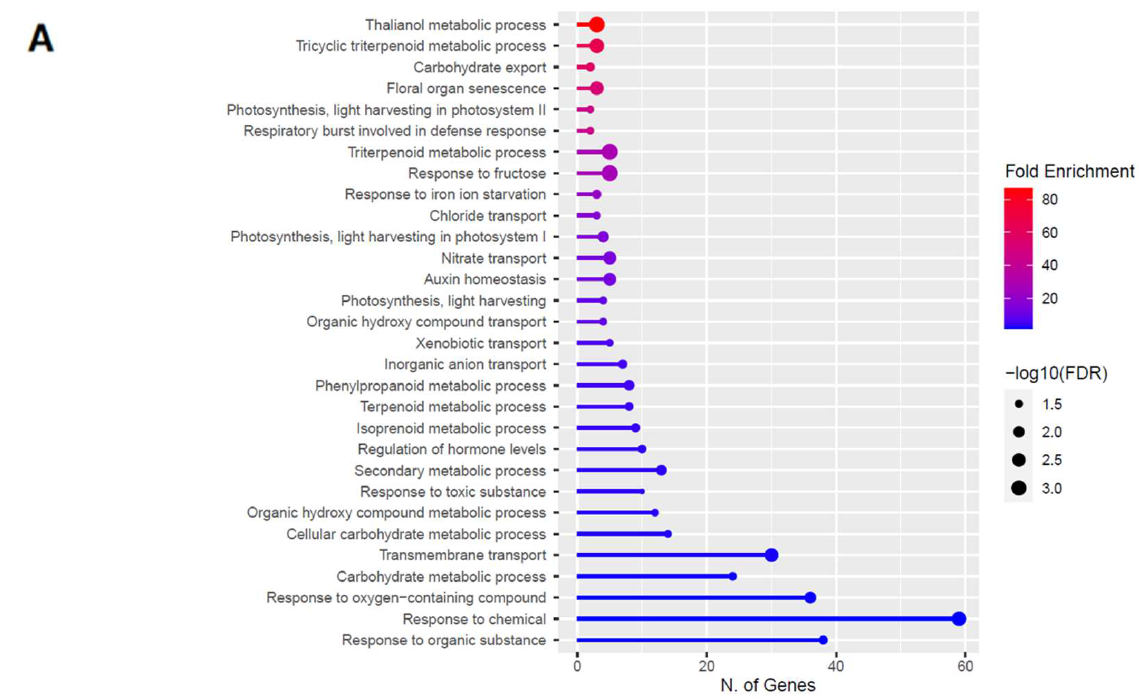
Figure 5. Gene enrichment analysis for upregulated genes after 60 s plasma treatment. Lollipop diagrams provide information about GO fold enrichment, significance (FDR in log10), and number of genes in each pathway. From top to bottom, GO categories are in the following order: ( A ) biological process, ( B ) cellular component, ( C ) molecular function, and ( D ) KEGG pathway.